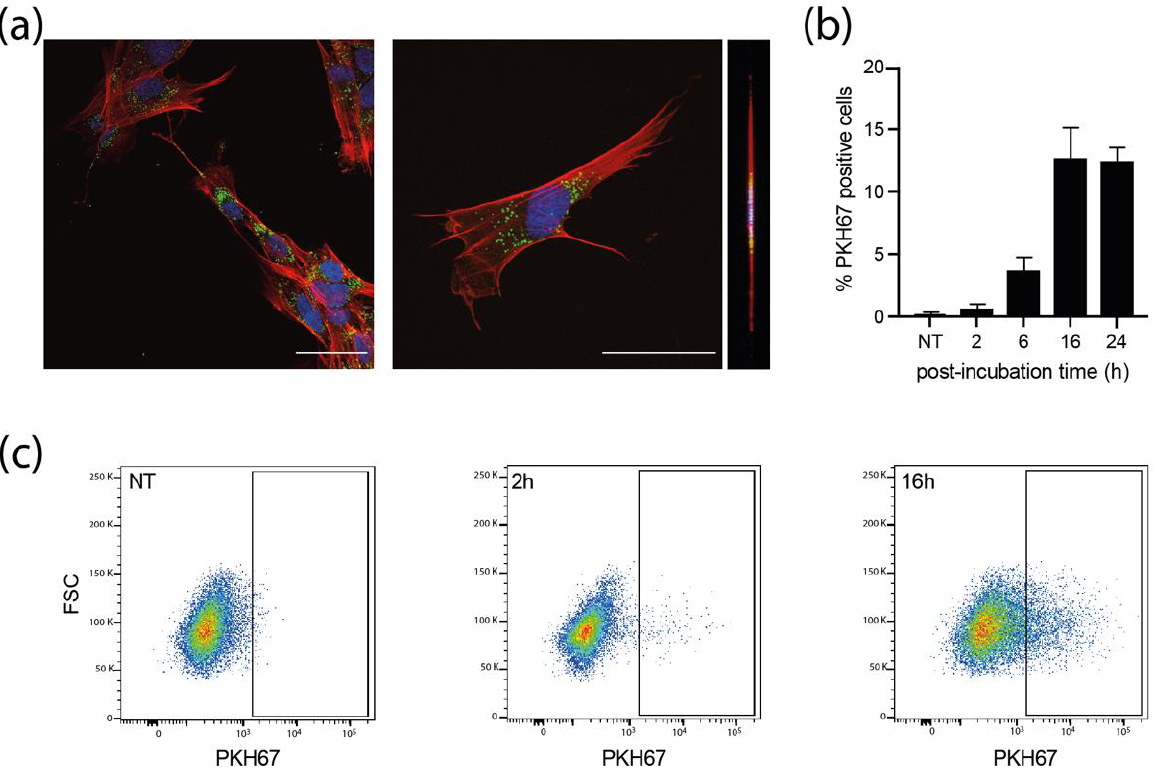
Figure 3. Internalization of sEVs isolated from non-infected HIPECs in fetal MRC5 cells. ( a ) Confocal images of fluorescence microscopy carried out on MRC5 cells after 16 h incubation with PKH67-labelled sEVs. Blue: DAPI; Red: Phalloidin; Green: PKH67. Scale bar: 100 μ m. Magnification = 63 X. The right image corresponds to the orthogonal projection of the cell z -axis. ( b ) Histogram representing the percentage of PKH67 positive cells along time, upon incubation of MRC5 cells with sEVs. Bars represent the mean ± SEM of three independent experiments. ( c ) Monitoring of PKH67-labeled sEVs internalization by MRC5 cells by flow cytometry. Dot plots represent MRC5 cell fluorescence upon incubation with PKH67-stained sEVs (200 sEVs/cell) for cells that have not been incubated with sEVs (NT, non-treated), or upon 2 h or 16 h of incubation. X -axis: PKH-67 fluorescence intensity; Y -axis: FSC. Gate indicates cells positive for PKH67.